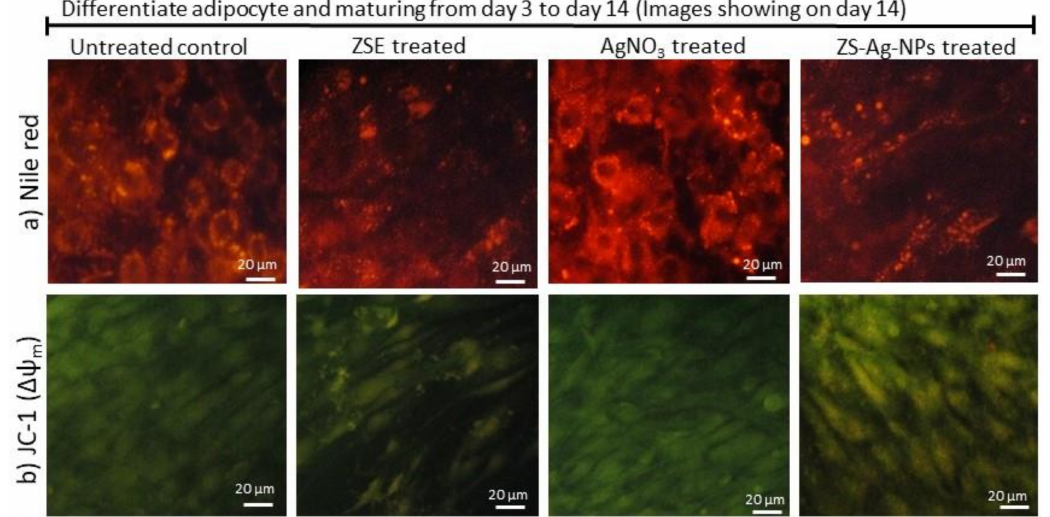
Figure 4. Nile red ( a ) and JC-1 staining ( b ) images of the vehicle control, ZSE, AgNO 3 , and ZS-Ag-NPs treated maturing adipocytes, after 14